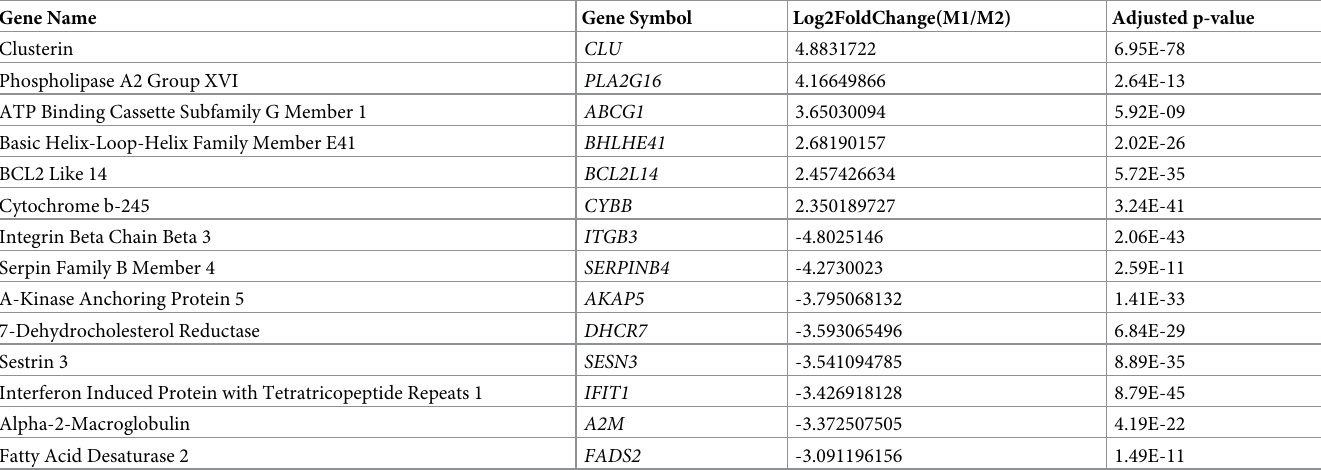
Table 1. Genes selected for siRNA-mediated gene